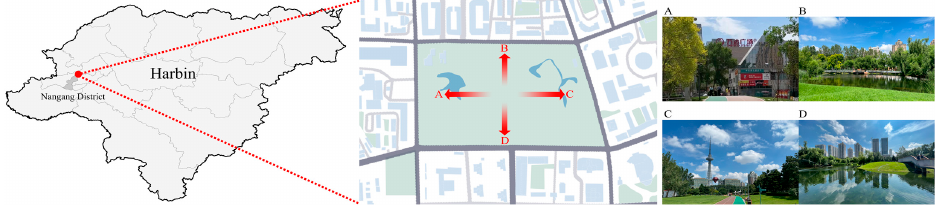
Figure 1. Park location and surrounding environment. ( A ) Park south side environment. ( B ) Park west side environment. ( C ) Park north side environment. ( D ) Park east side environment.